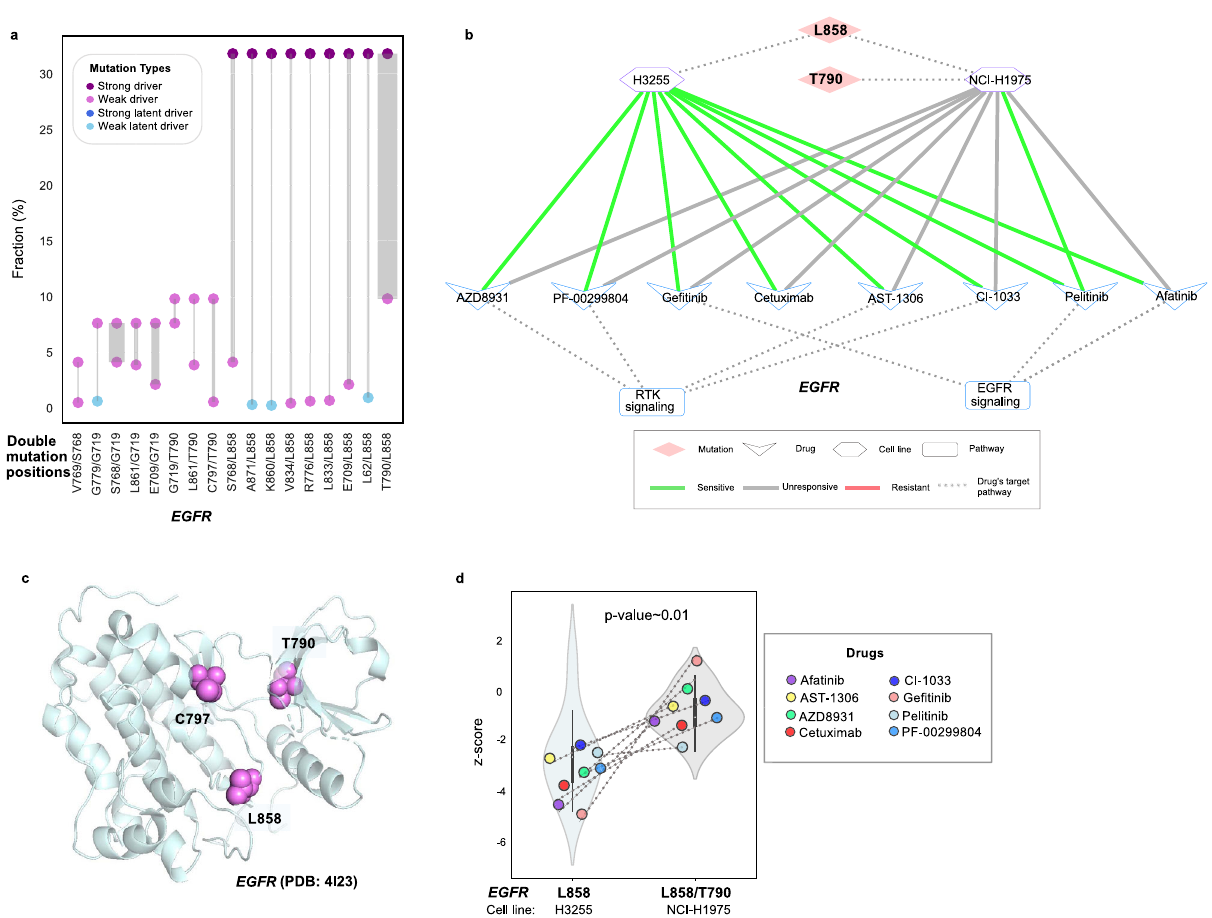
Fig. 4 Structural and clinical aspects of EGFR double mutations. a Paired dot plot of EGFR double mutations. Each paired dot represents one double mutation. Dots are colored according to their type, driver (purple), weak driver (orchid), strong latent driver (blue), and weak latent driver (sky blue). Line size connecting the dots is proportional to the number of tumors with double mutations. b EGFR mutation doublets in lung cancer cell lines and their response to drugs in network representation. Dashed lines connecting cell line nodes (hexagon) to mutation nodes (diamond) indicate cell lines that harbor corresponding mutations. Green and red lines connecting cell line nodes (hexagon) to drug nodes (V-shaped) represent sensitivity and resistance of the cell lines to the corresponding drugs, respectively. Dashed lines between the drug nodes (V-shaped) and pathway nodes (rectangle) indicate that, the drugs have target(s) in the corresponding pathways. c Representation of double mutations in EGFR structure. d EGFR mutation doublets in lung cancer together with the violin plot that shows the response to RTK inhibitor in double mutant and single mutant cell lines. More negative z -score means more sensitivity and more positive z -score means more resistance to the drug